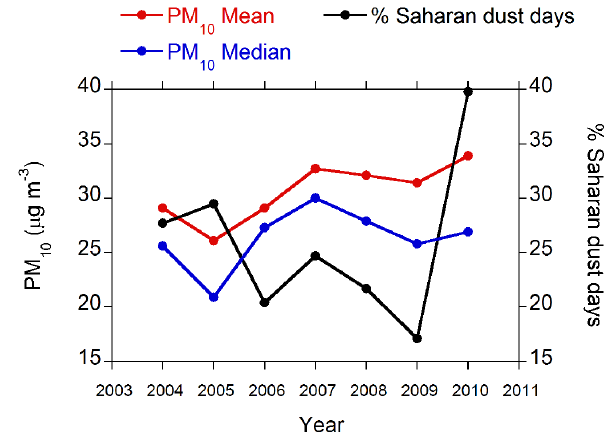
Fig. 3. Annual PM 10 mean (red dots) and median (blue dots) on the left y axis. Percentage of Saharan dust episodes (black dots and right y axis) revealed by nssCa for the period